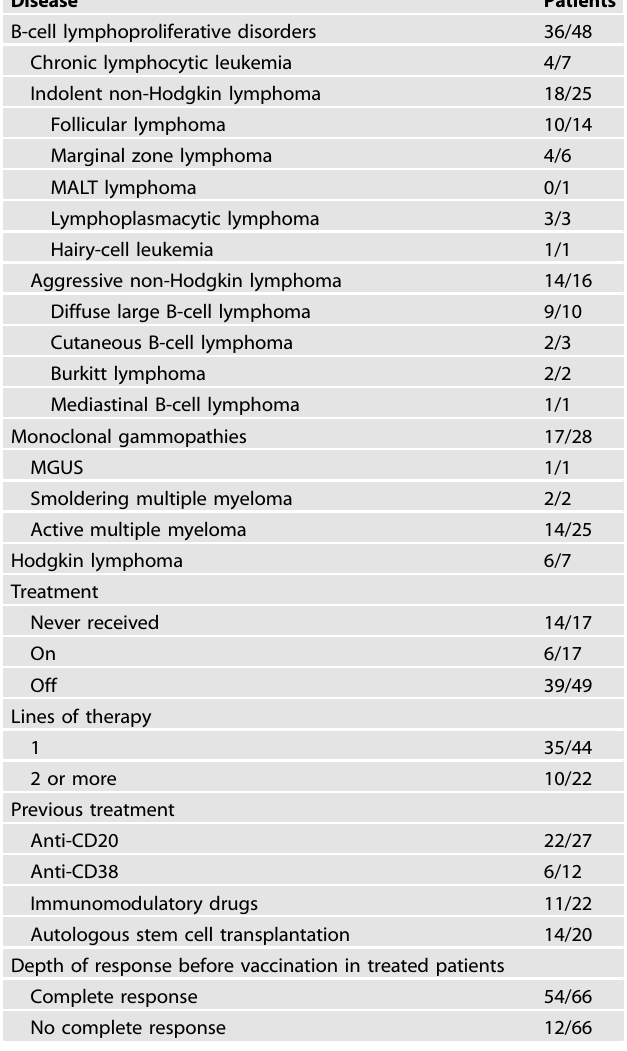
Table 1. Characteristics and type of vaccine for COVID-19 administered to health care practitioners (HCPs) and patients with hematological malignancies.